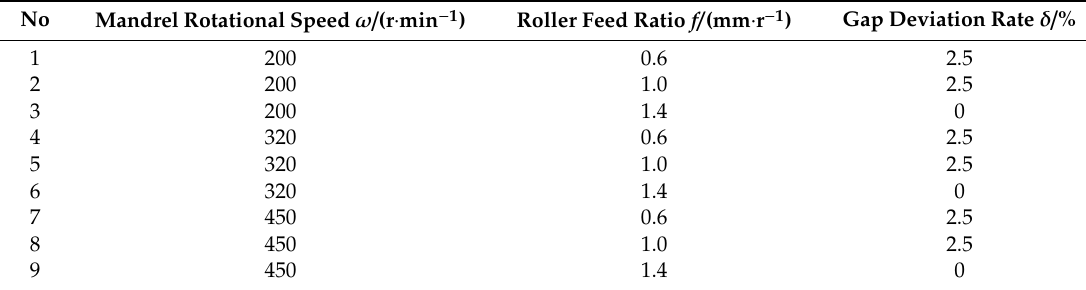
Table 4. Process parameters for the spin-formed conical.